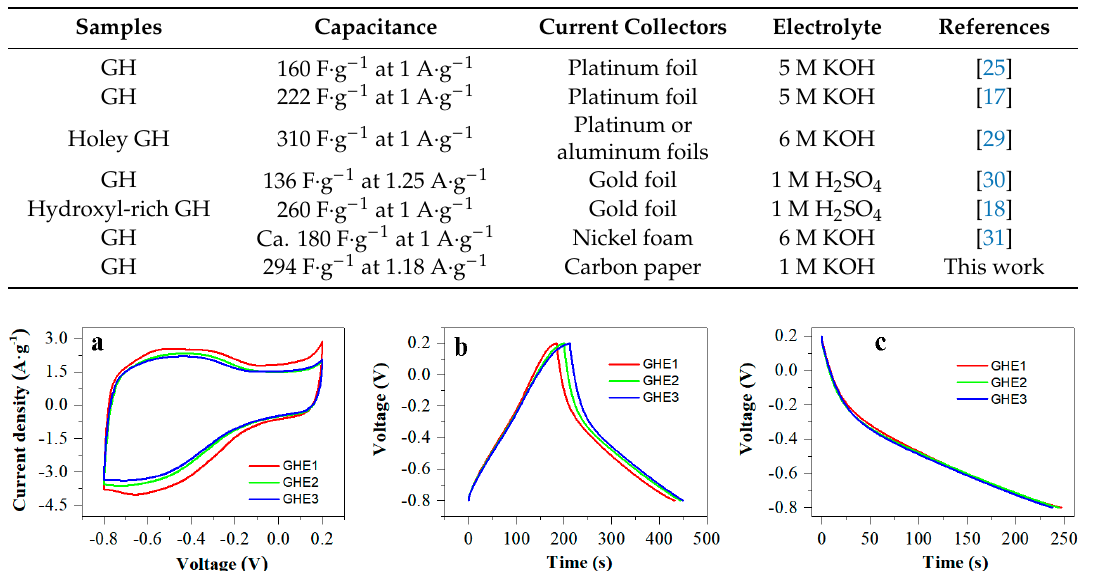
Figure 4. CV plots at various scan rates ( a ), GCD curves at different charging/discharging current densities ( b ) and specific capacitances versus current densities ( c ) for a GHE1 ‐ based supercapacitor. Table 1. Comparison of the gravimetric capacitance for GH ‐ based electrodes on different current collectors. Table 1. Comparison of the gravimetric capacitance for GH-based electrodes on di ff erent current collectors.